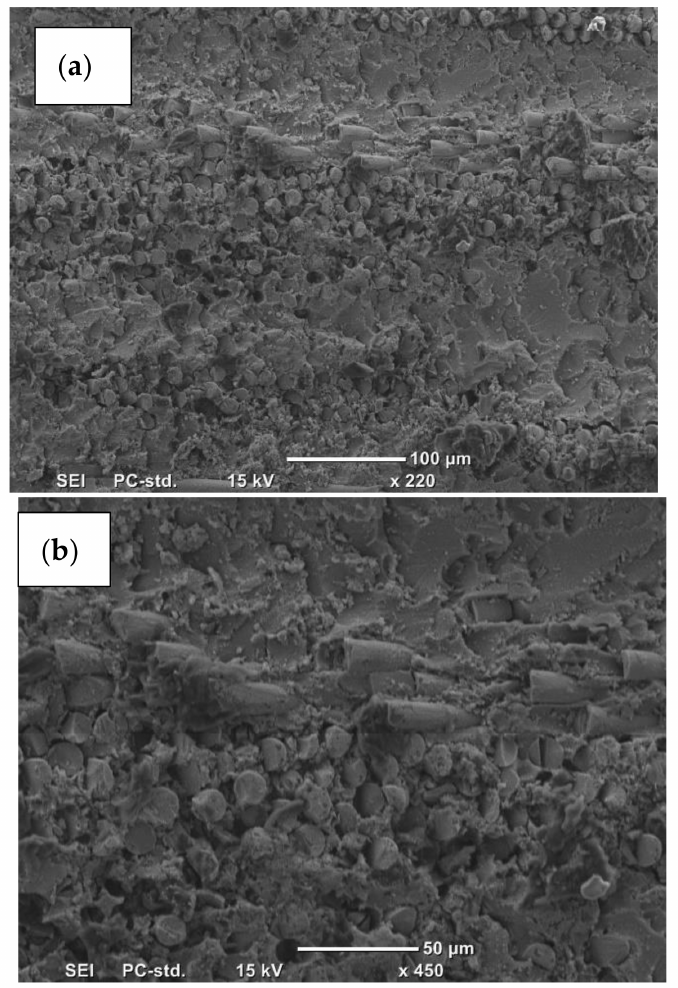
Figure 11. Micrographs of the worn surface of GFRP with AP–O fibres following an applied load of 30